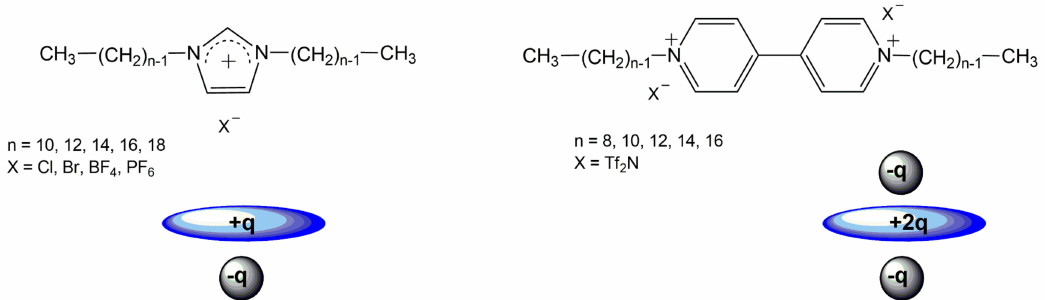
Figure 1. (top) Structural formula of some ionic liquid crystals (ILCs) with 1:1 stoichiometry (left, Reference [36,37]) and 1:2 stoichiometry (right, Reference [5,38–40]). (Bottom) schematic representation of the ion pairs of Gay–Berne (GB) and Lennard-Jones (LJ) particles used in the